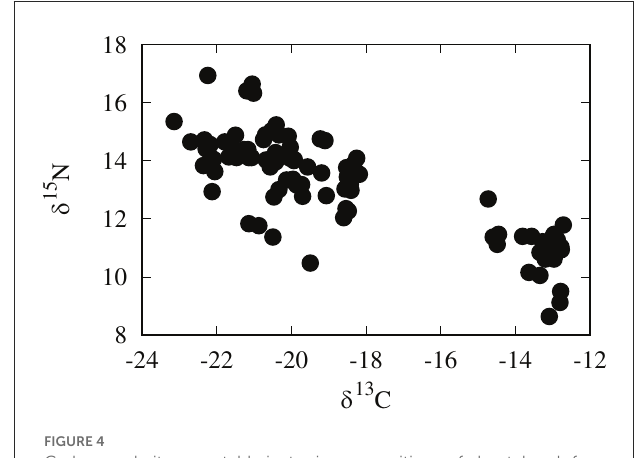
FIGURE4 Carbon and nitrogen stable isotopic compositions of cheetah cub fur in per mil PDB and AIR, respectively.